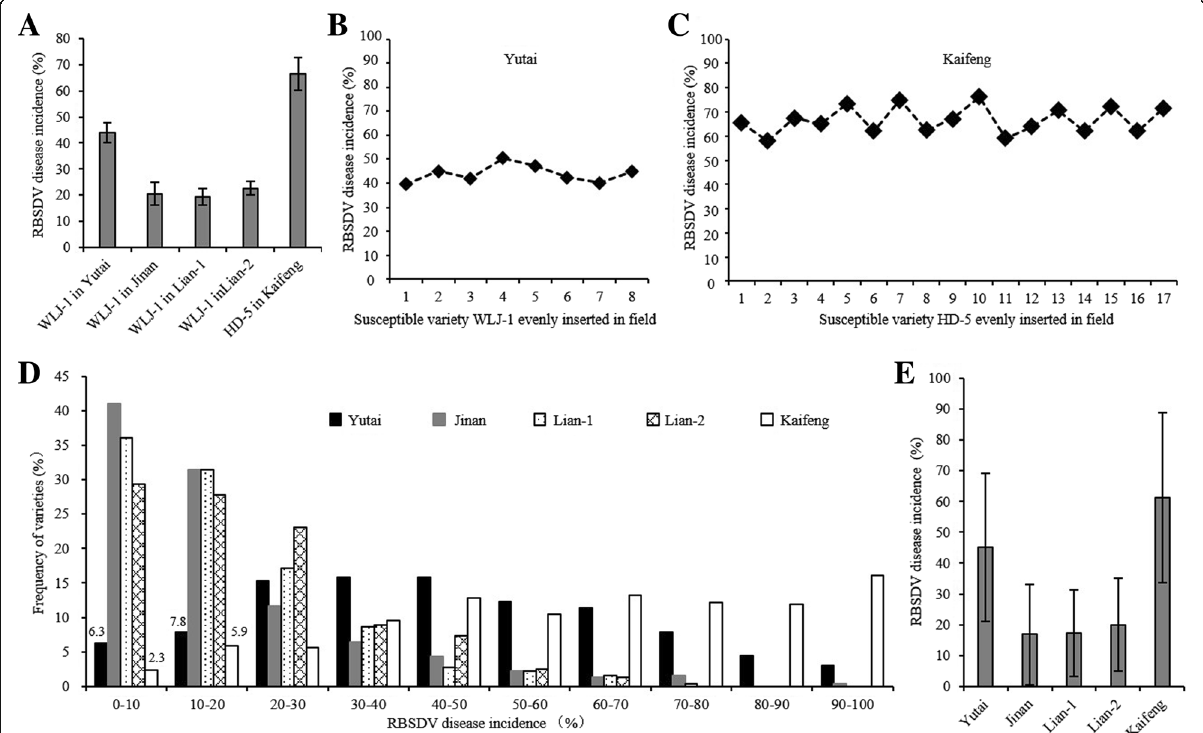
Fig. 1 Phenotypes of the RDP1 and the susceptible control for the RBSDV disease at different locations. a The RBSDV disease incidences of the susceptible controls, WLJ-1 and HD-5. b and c RBSDV disease incidences of susceptible controls planted in different parts of the field in Yutai ( b ) and Kaifeng ( c ). d Frequency distributions of varieties with different disease incidences of rice at different locations. e Average RBSDV disease incidences of all varieties at each